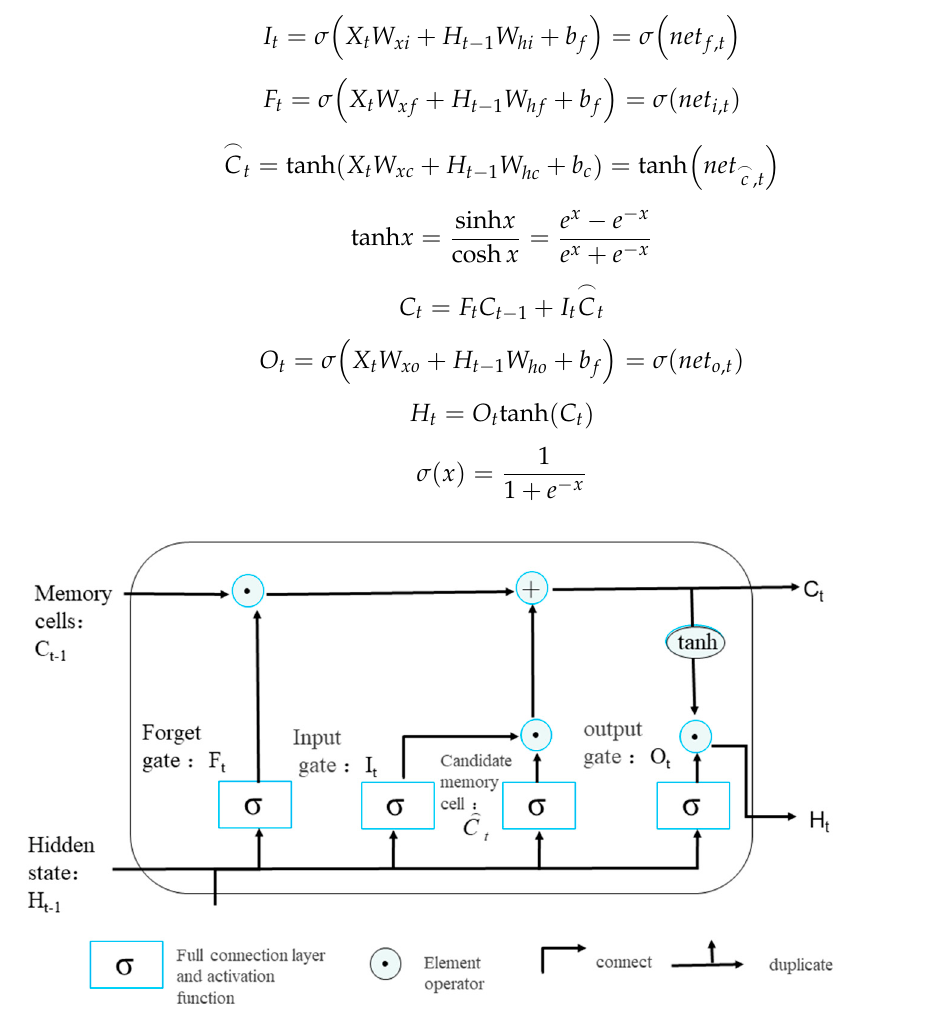
Figure 1. Neuron structure of LSTM model.